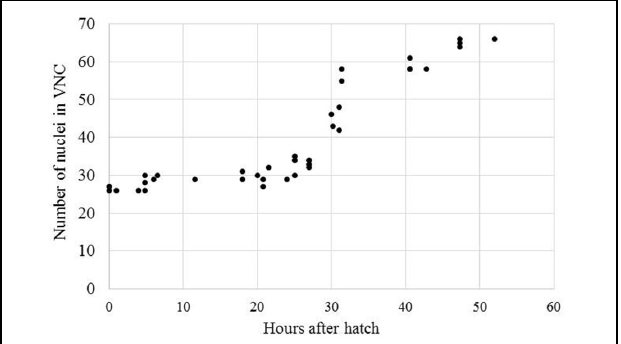
FIGURE 4 | Aphelenchus avenae undergoes a post-hatch increase in the number of VNC neurons during J2. The number of VNC nuclei was examined with DIC microscopy in synchronized A. avenae nematodes at various time-points following hatch. The molt from J2 to J3 occurs at approximately 36 h after hatching. Each data point represents an individual